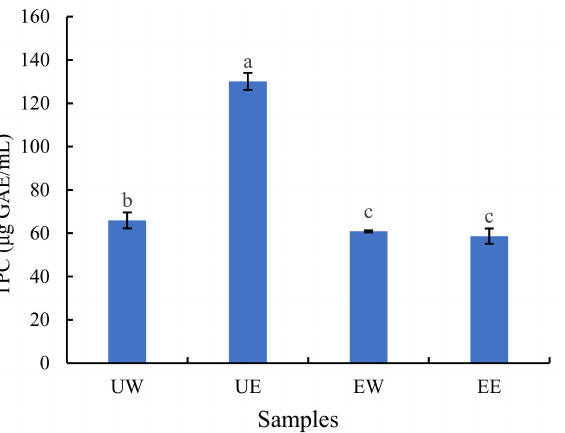
Figure 1. The total phenolic content (TPC) among the four different extracts. Different letters represent significant differences according to Duncan’s test ( p < 0.05). UW = ultrasound-assisted water extraction, UE = ultrasound-assisted ethanol extraction, EW = enzymatic-assisted water extraction, EE = enzymatic-assisted ethanol extraction.